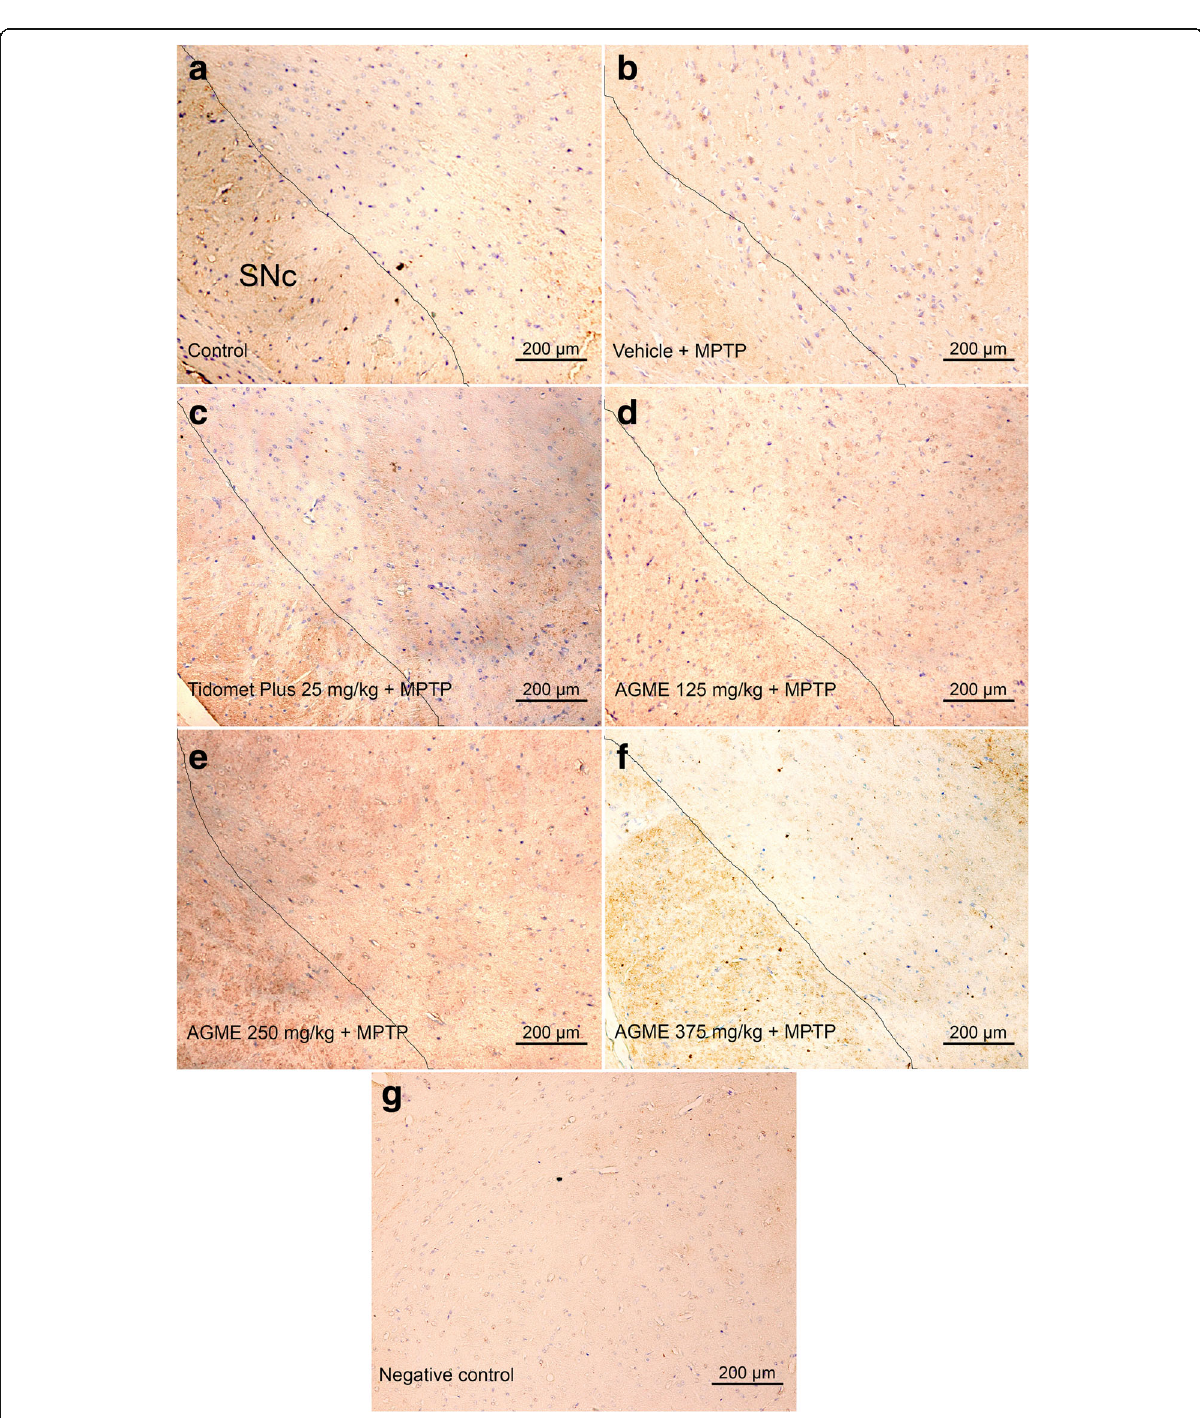
Fig. 6 Effect of AGME on the MPTP-induced decrease in TH immunostaining in the substantia nigra of mice. (A) Representative microphotographs showing the control group ( a ), the vehicle (NSS) + MPTP group ( b ), the Tidomet Plus (25 mg/kg BW) + MPTP group ( c ), the AGME (125 mg/kg BW) + MPTP group ( d ), the AGME (250 mg/kg BW) + MPTP group ( e ), the AGME (375 mg/kg BW) + MPTP group ( f ), and a negative control without anti-TH antibody ( g